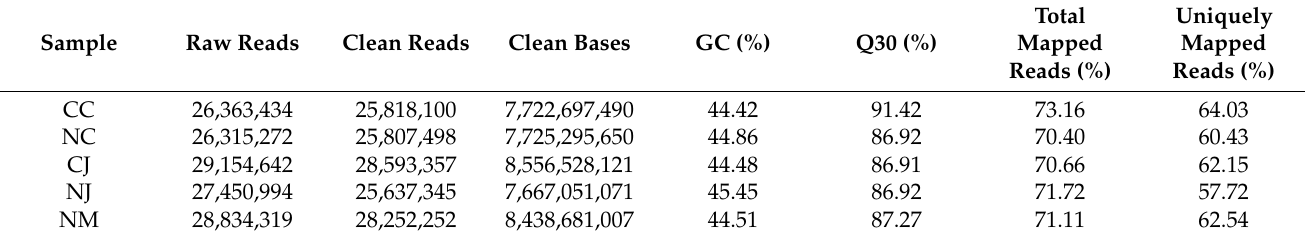
Table 1. Statistical results of transcriptome sequencing data and mapping rate.